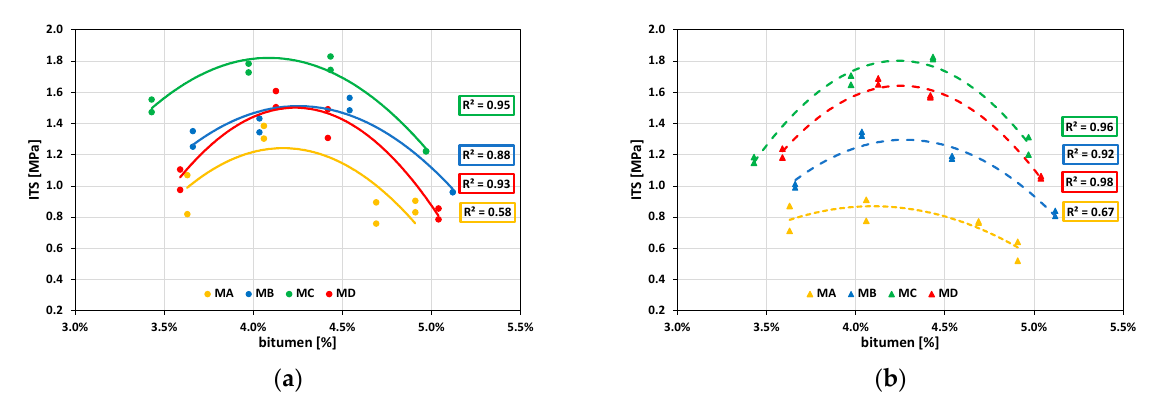
Figure 5. Mijk stability. ( a ) MAjk; ( b ) MBjk; ( c ) MCjk; ( d ) MDjk.